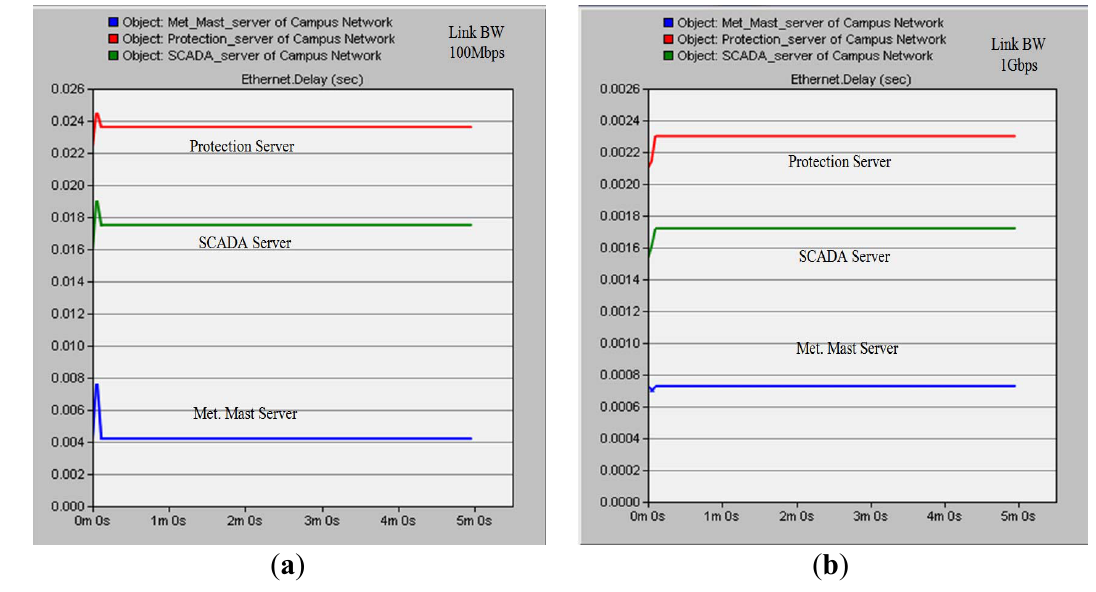
Figure 12. ( a ) Average ETE delay for medium-scale WPF with link BW 100Mbps; ( b ) Average ETE delay for medium-scale WPF with link BW